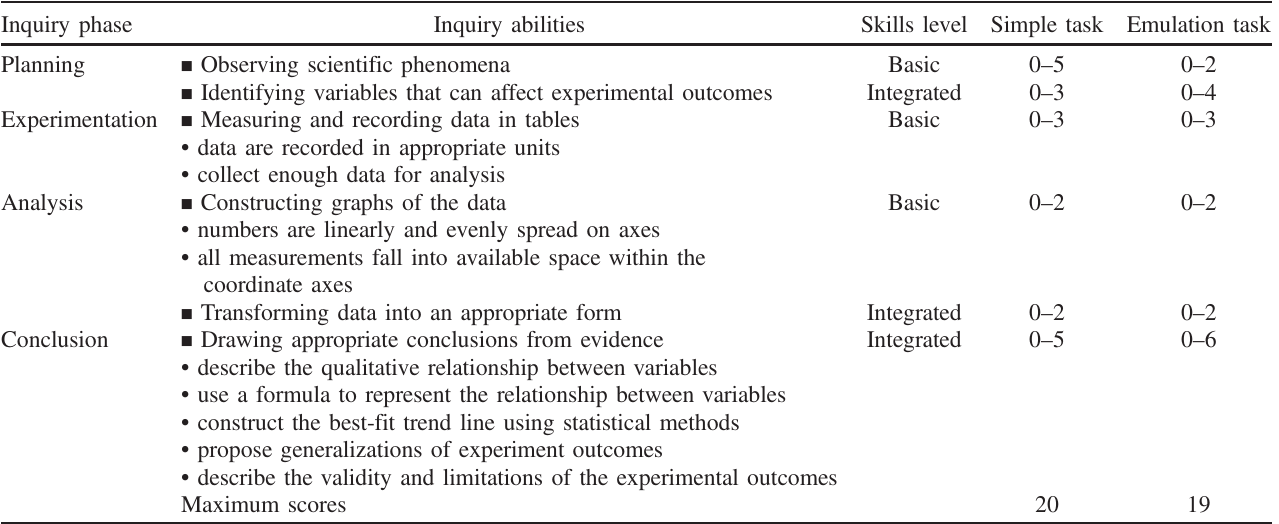
TABLE I. A scoring framework of the inquiry performance assessments.